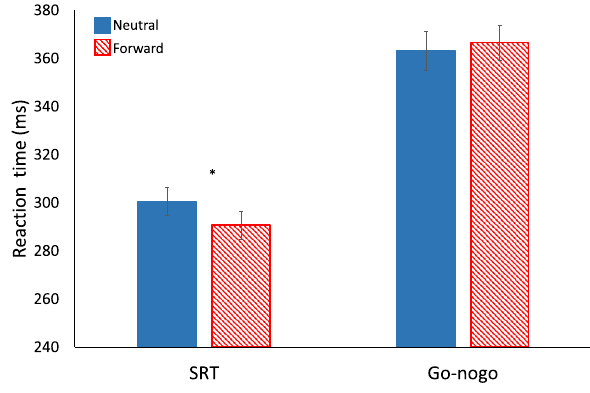
Fig. 6 Reaction time during simple reaction time (SRT) and go- nogo tasks, for neutral (solid blue) and forward (red stripes) condi- tions. Reaction times are measured in ms from stimulus onset to button press. Error bars represent standard error. Asterisks repre- sent significant effects ( p < 0.05). Paired t-tests showed that reac- tion time was faster in the flexed neck condition for SRT, but there was no difference in reaction time for during